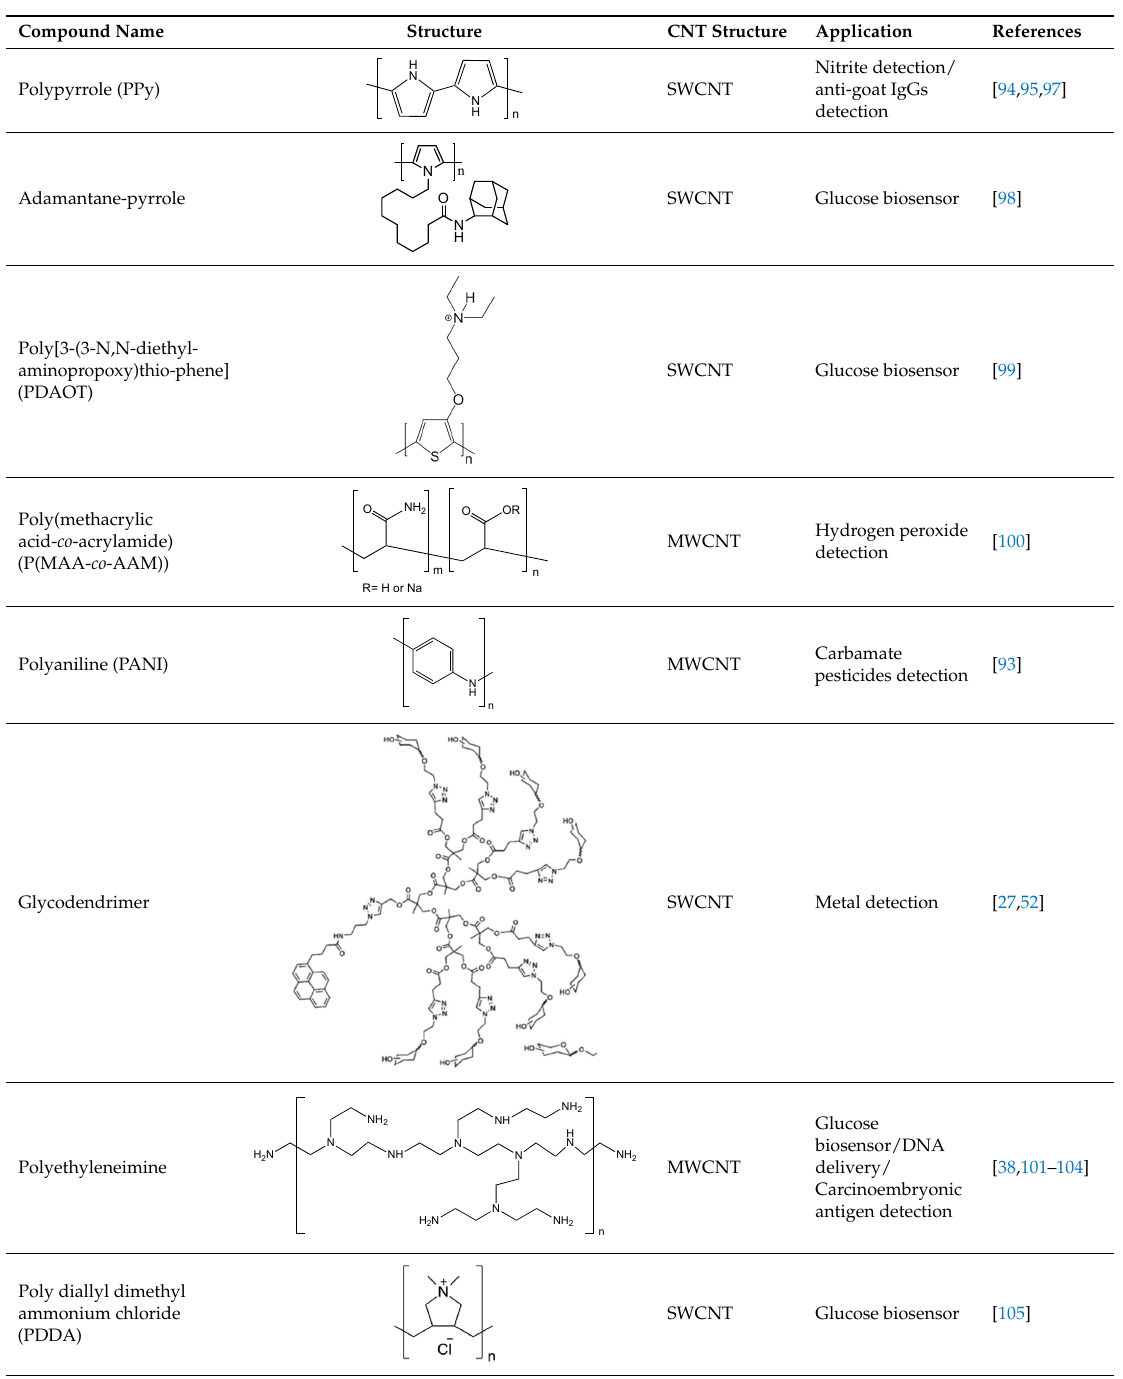
Table 3. List of polymers used for non-covalent functionalization of carbon nanotubes.